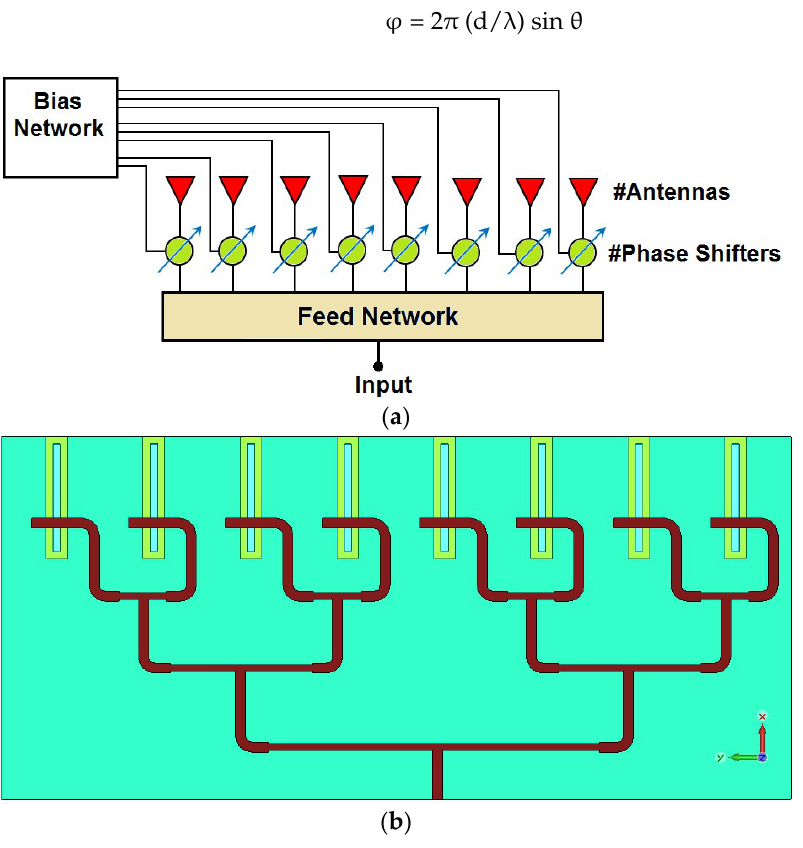
Figure 3. ( a ) Phased array architecture and ( b ) typical 1:8 feed network for the array design.